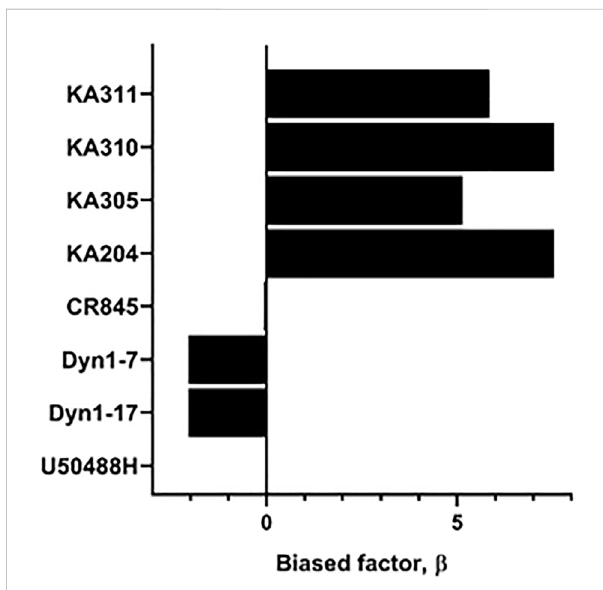
FIGURE 8 Determination of bias factor β , relative to U50488H, for control compounds and agonist peptides. Positive values indicate a bias towards cAMP modulation, whereas negative values indicate a bias towards pERK. U50488H by de fi nition has a bias of